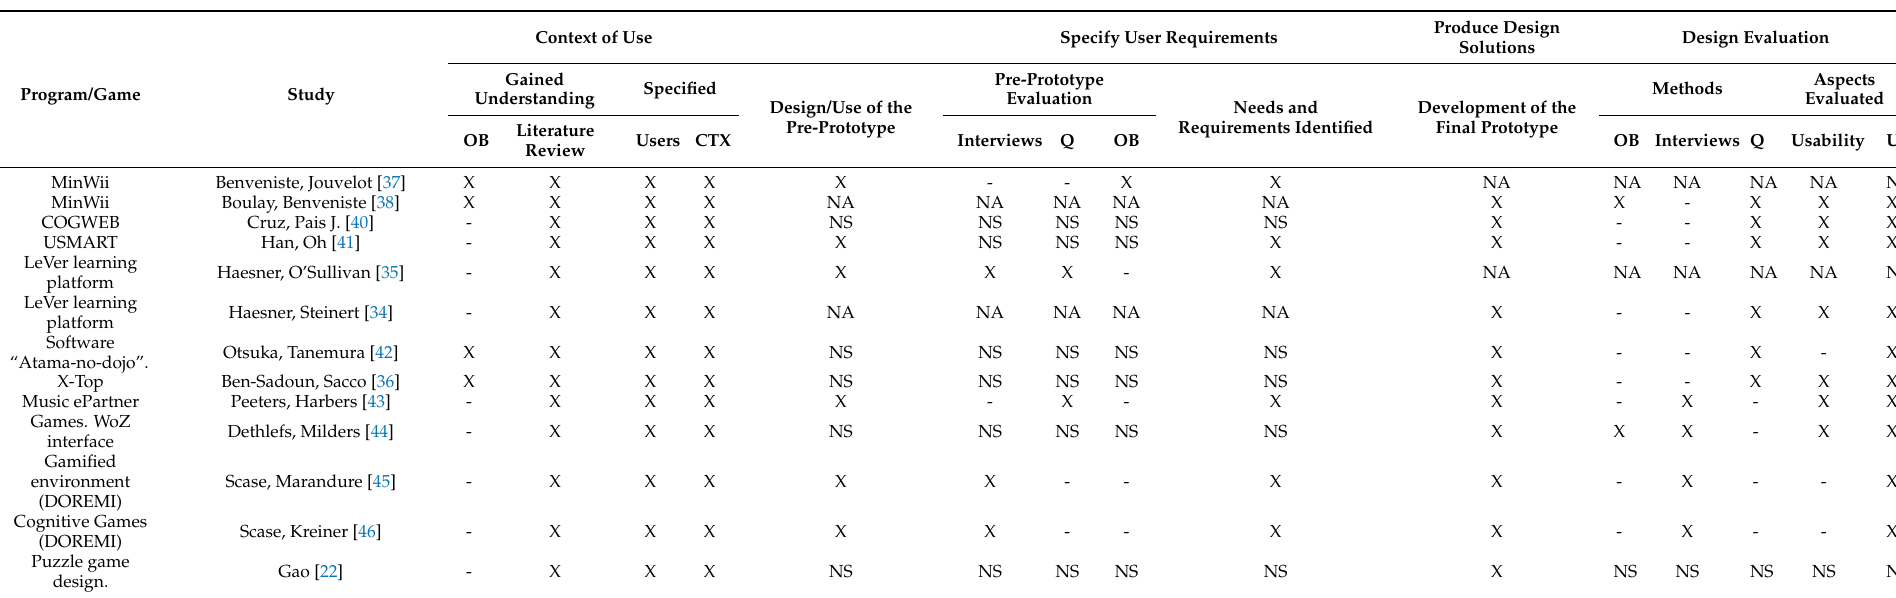
Table 2. Methodological design in the development of CCT programs for people with MCI and mild dementia according to ISO9241-210 (21)